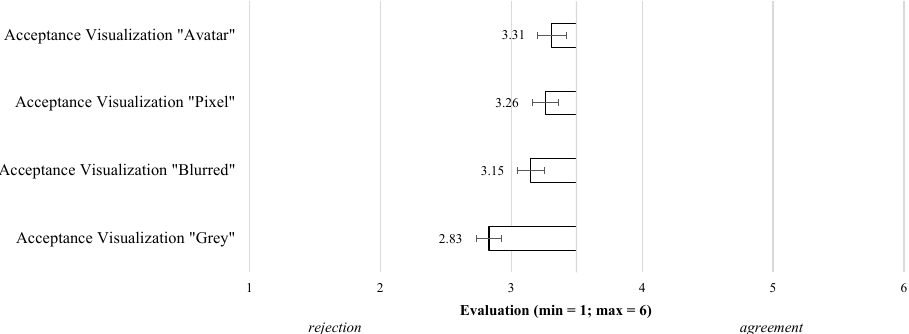
Figure 7. Acceptance of the different visualizations of video-based AAL technology (n =